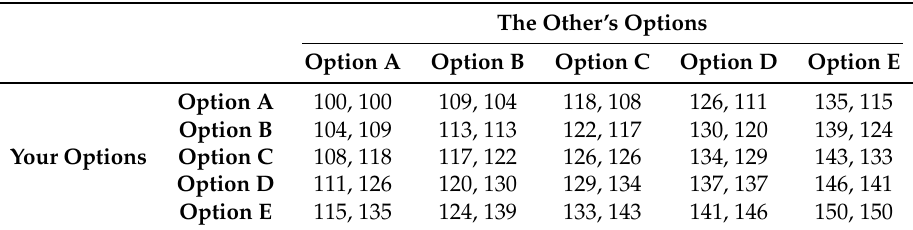
Table A3. Recomposition of task number two into a matrix game.